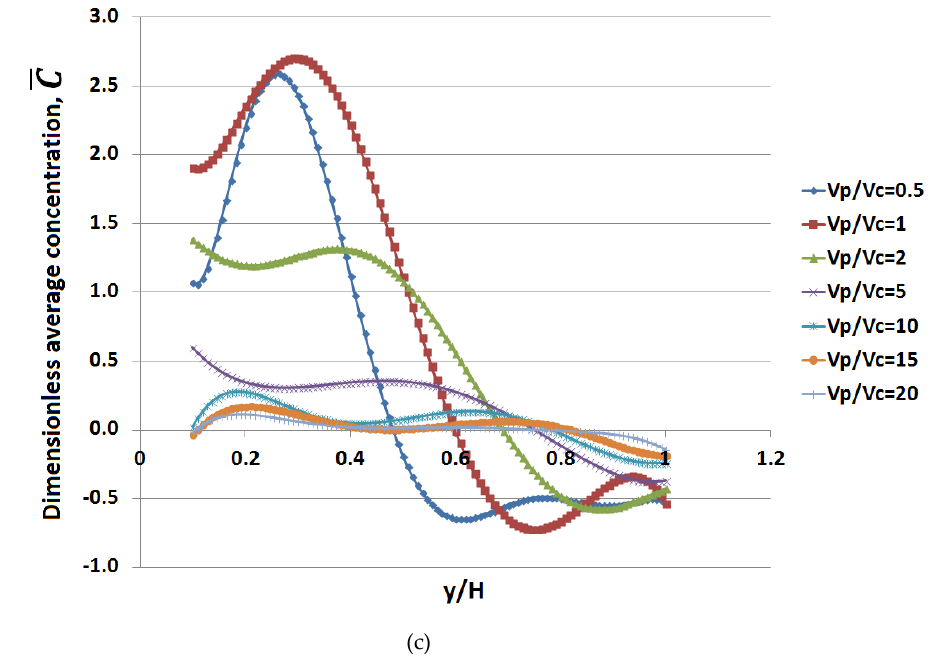
Figure 5. Average concentration for di ff erent velocity ratios and for di ff erent cases, ( a ) θ = 30 ◦ , ( b ) θ = 45 ◦ , ( c ) θ = 60 ◦ .